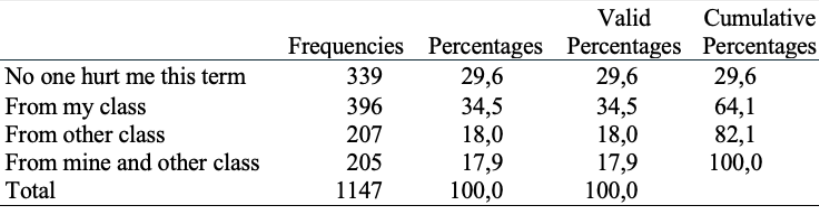
Frequencies and percentages of the multiple ways of